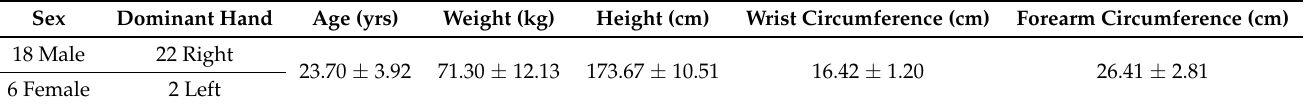
Table 1. Summary of participant demographics.